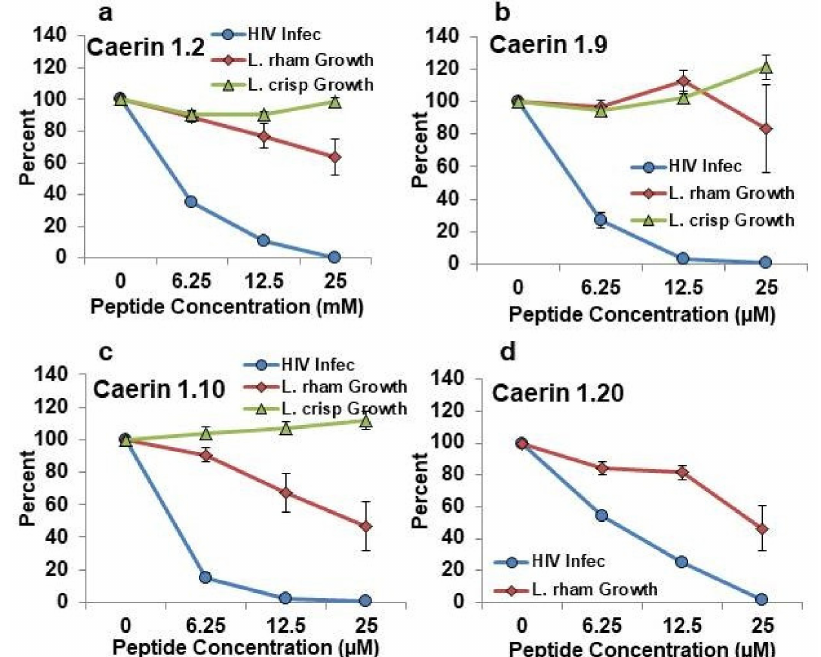
Figure 5. Comparison of the e ff ects of caerin 1 peptides on percent of HIV infection of target T cells (blue) with percent growth of Lactobacillus rhamnosus (red) and Lactobacillus crispatus (green). ( a ) caerin 1.2; ( b ) caerin 1.9; ( c ) caerin 1.10; ( d ) caerin 1.20. HIV percent infection was previously published (11) and average percent growth of the lactobacilli in the presence of each peptide is new for this study and presented above in Figures 1–3.